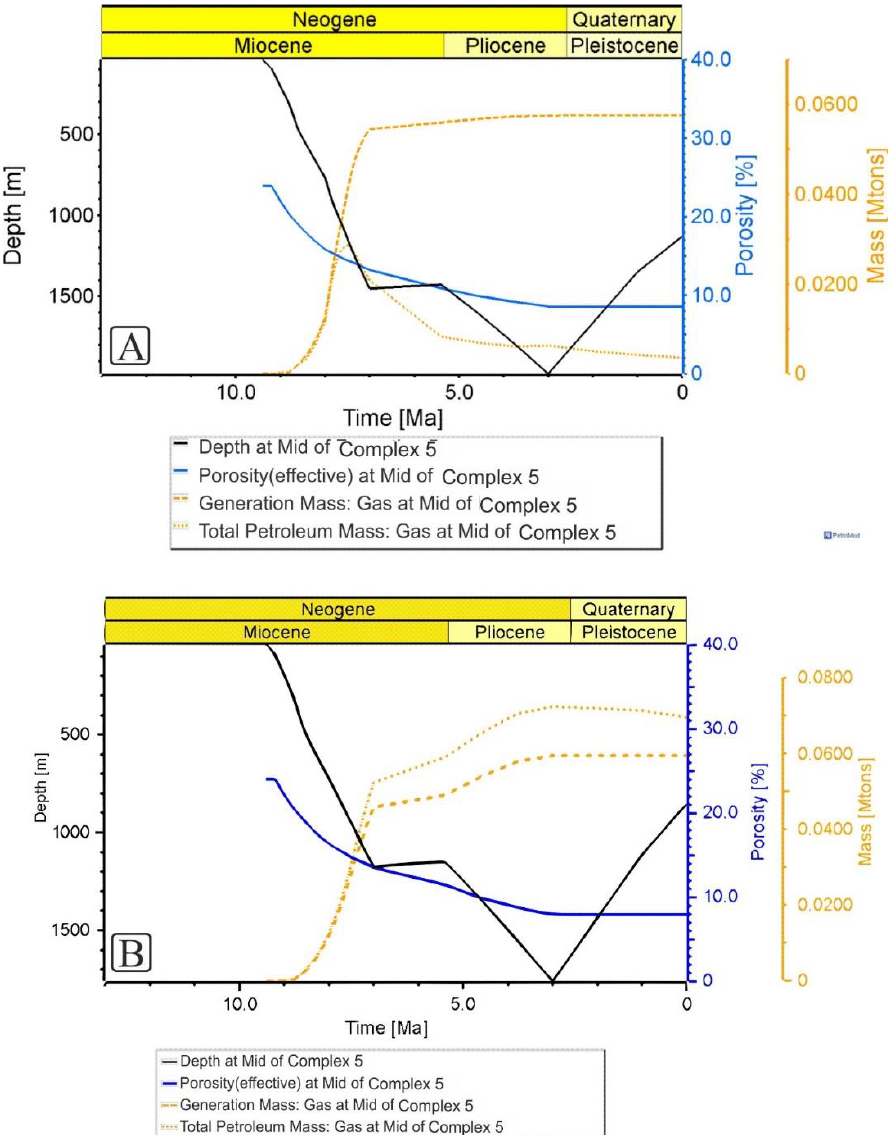
Figure 15. Comparison of diverse gas accumulation conditions (marked as total petroleum mass curve) in Miocene mudstones within Complex 5 located at the foreland of the Carpathian Orogen front, at about 1000-m burial depth: ( A ) Location within Complex 5 with unfavorable accumulation conditions; ( B ) location within Complex 5 with favorable accumulation conditions. Values of generated and accumulated hydrocarbons refer to the area of 700-m × 700-m calculation block of the model and 100-m thickness of sediments.